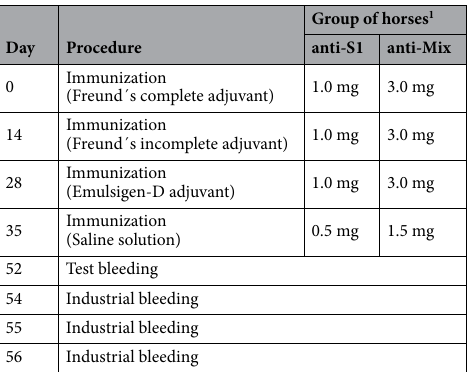
Table 1. Immunization and bleeding protocol for anti-SARS-CoV-2 hyperimmune plasma production. 1 anti-S1 group was immunized with S1 protein alone, and anti-Mix group with a mixture of equal parts of S1, N, and SEM mosaic proteins (1